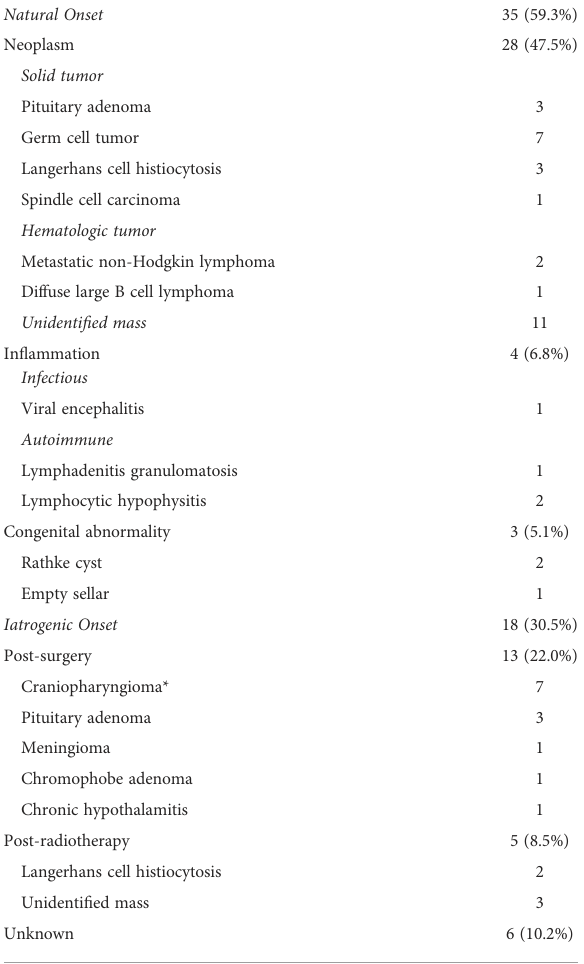
TABLE 3 Causes of hypothalamic dysfunction